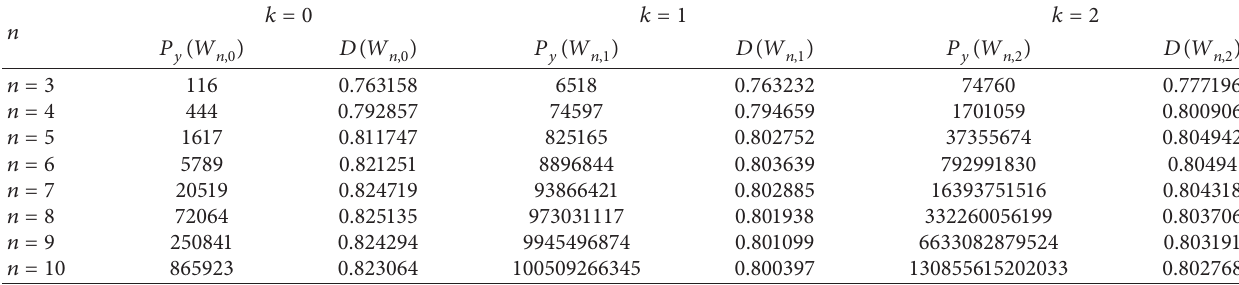
( n � 3 , 4 , . .. , 10 ; k � 0 , 1 , 2 ) . n,k